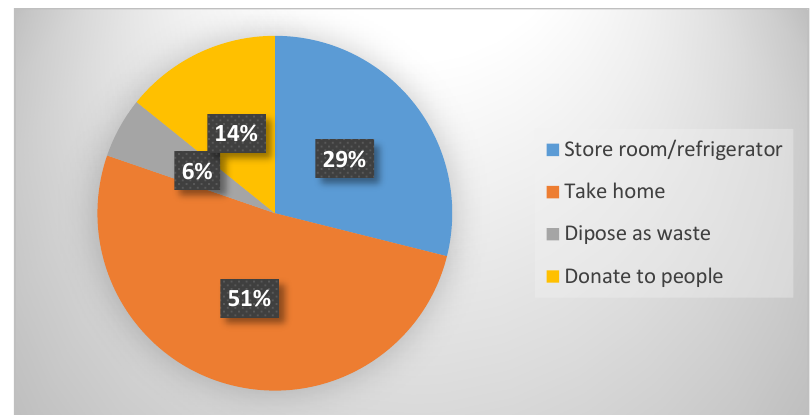
Figure 1. What food vendors did with their cooked left-over food.